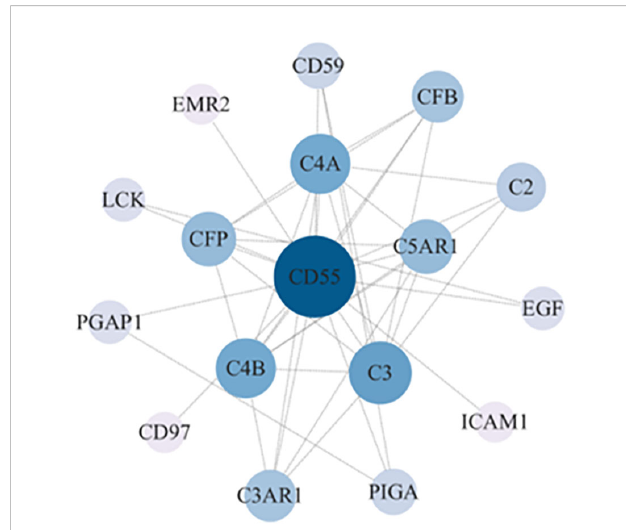
FIGURE 6 CD55 PPI network analysis. The PPI network of CD55 and related proteins were visualized by the STRING database. PPI, protein – protein interaction.